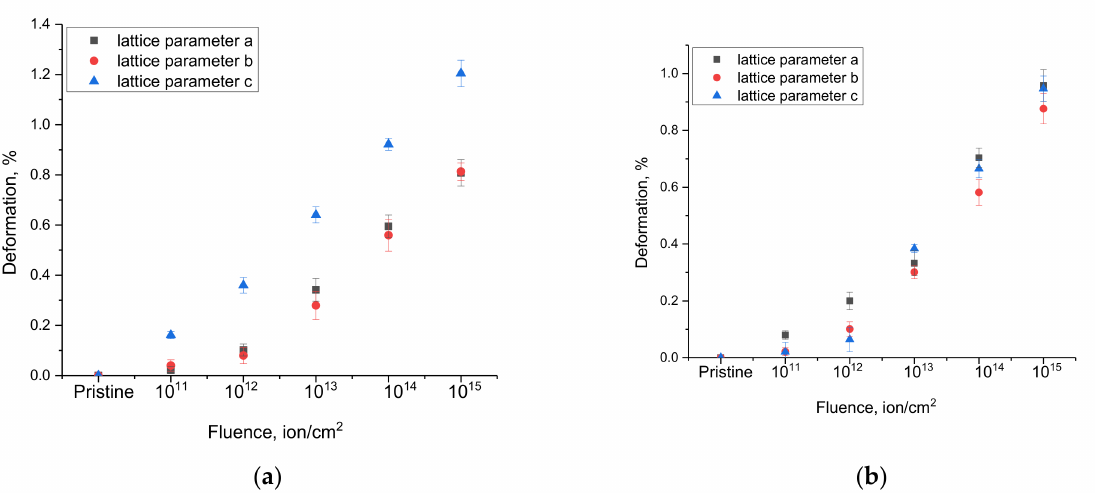
Figure 5. Change in the crystal lattice deformation value as a result of external influences: ( a ) irradiation with Kr 15+ ions; ( b ) irradiation with Xe 22+ ions (the amount of deformation is shown in